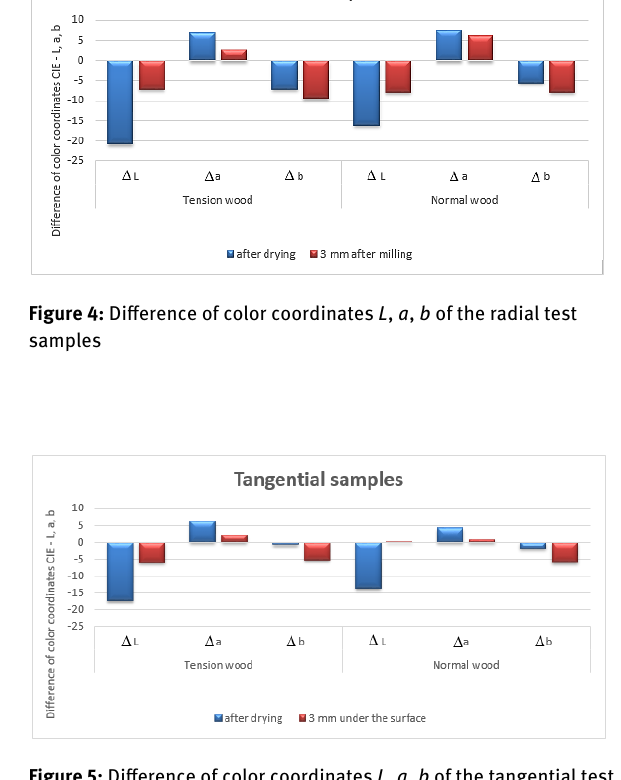
Figure 5: Difference of color coordinates L , a , b of the tangential test samples